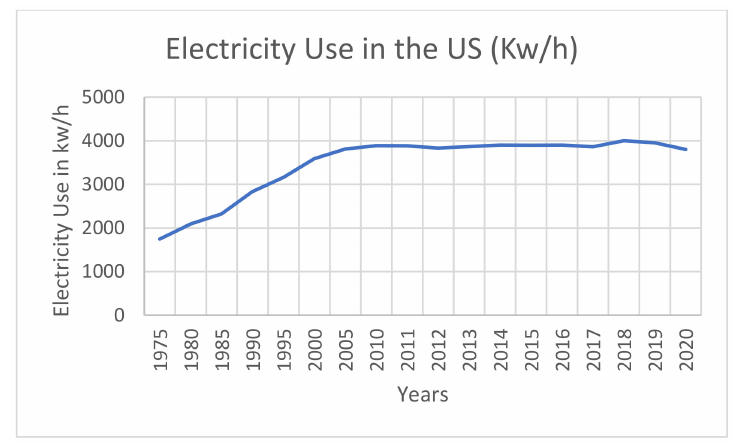
Figure 1. Electricity use in the US. Adapted from [1]. The basic IoT architecture contains four main components: sensors, gateway, cloud, and end user/application. These components are connected as shown in Figure 2 below.